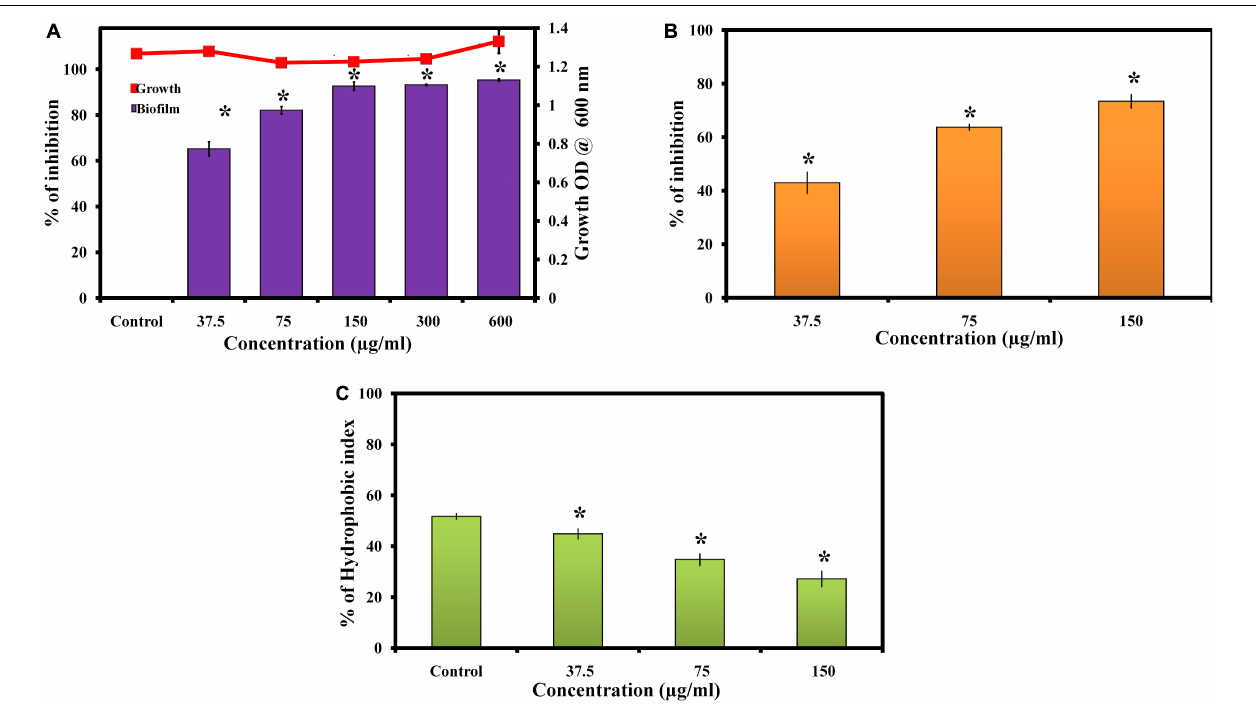
FIGURE 1 | (A) Effect of morin on growth and biofilm of C. albicans . Data are presented as means ± SD. *Indicates statistical significance ( p < 0.05). (B) Inhibitory effect of morin on C. albicans exopolysaccharide production. Data are presented as means ± SD. *Indicates the statistical significance ( p < 0.05). (C) Effect of morin on cell surface hydrophobicity of C. albicans . Data are presented as means ± SD. *Indicates statistical significance ( p <